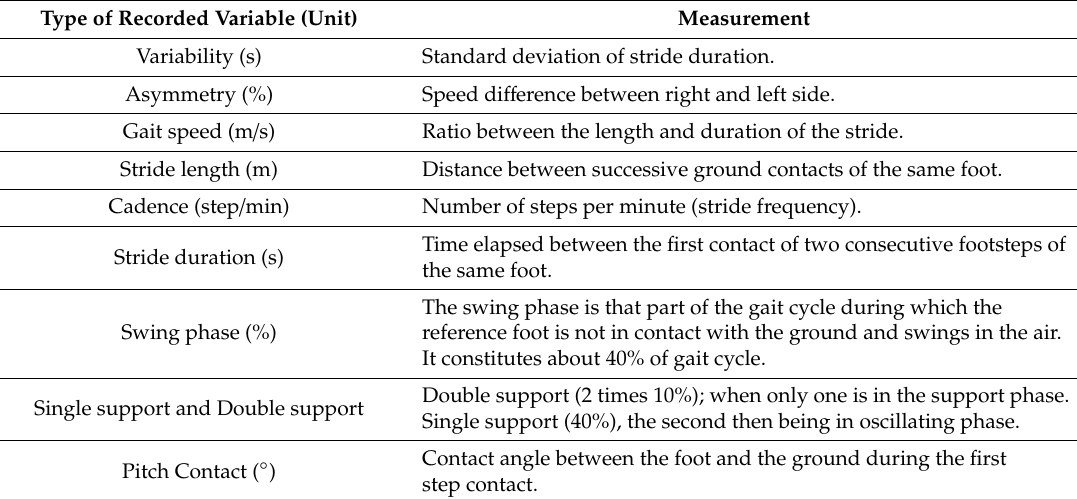
Table 1. The table shows all spatiotemporal parameters of gait analyzed during the pre- and post- mechanical peripheral